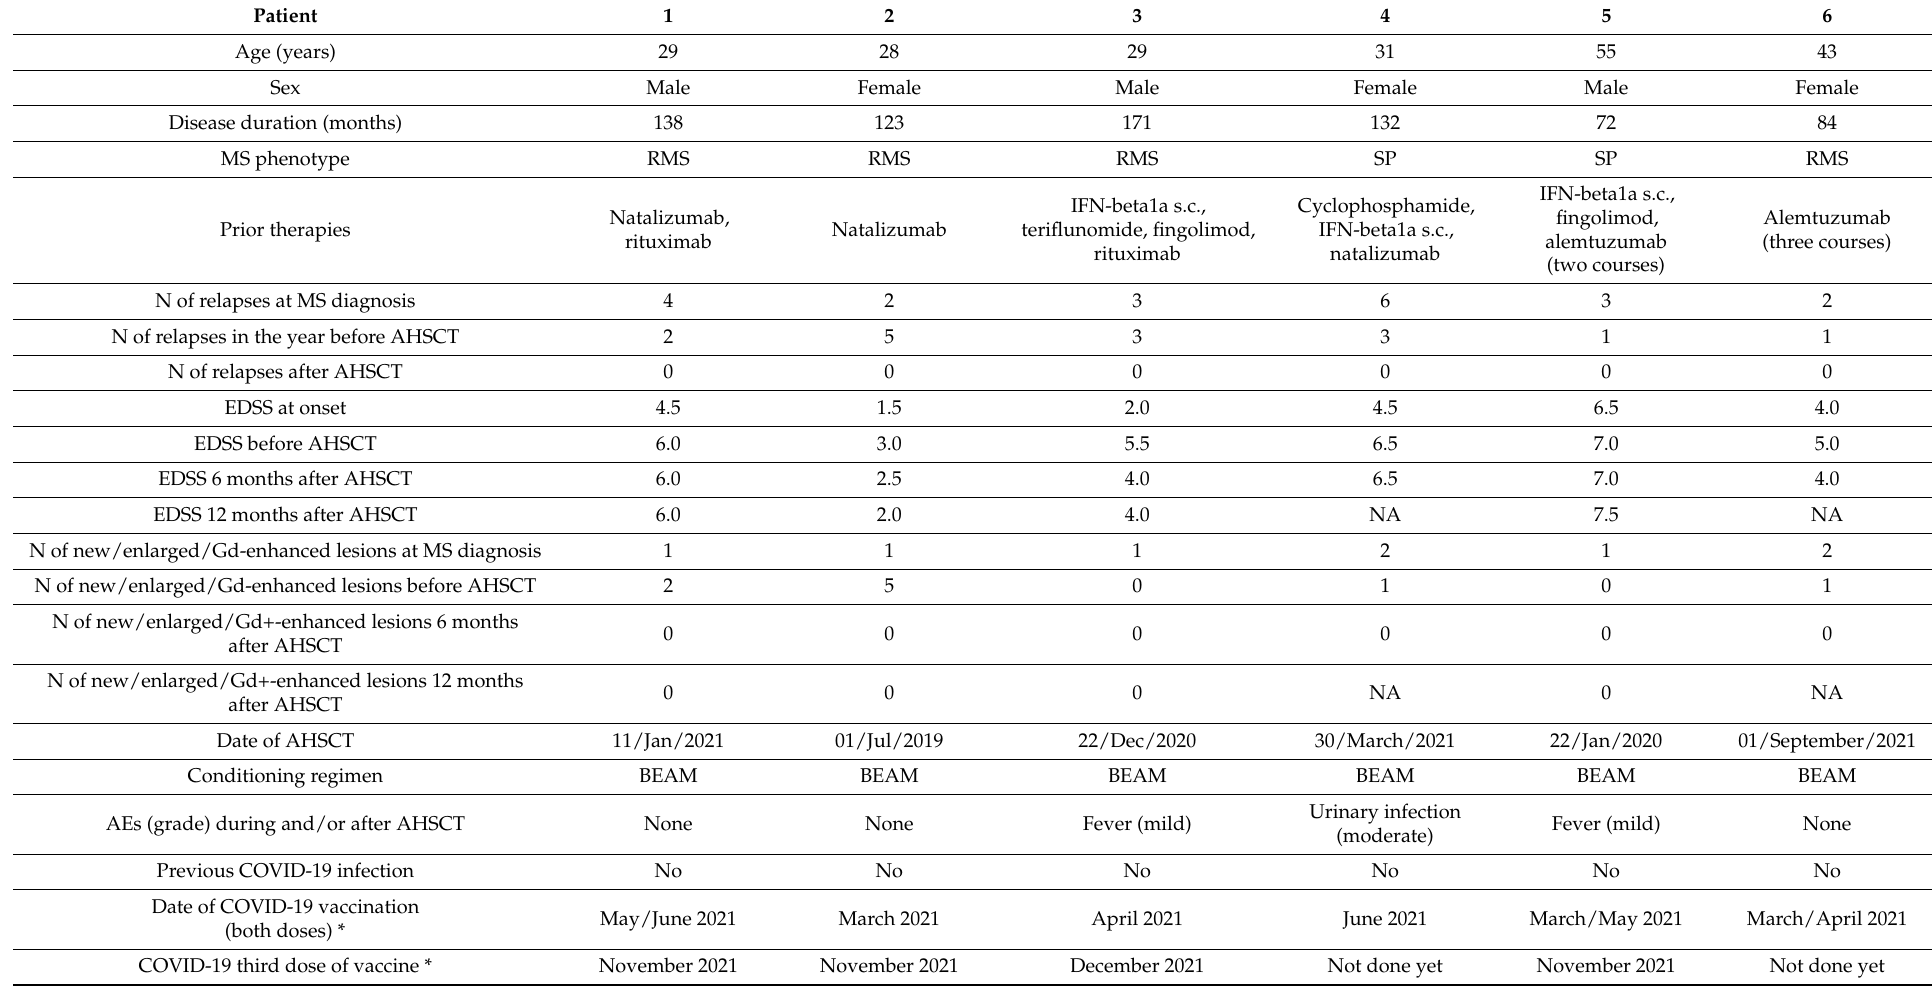
Table 1. Demographical and clinical characteristics of the patients who received